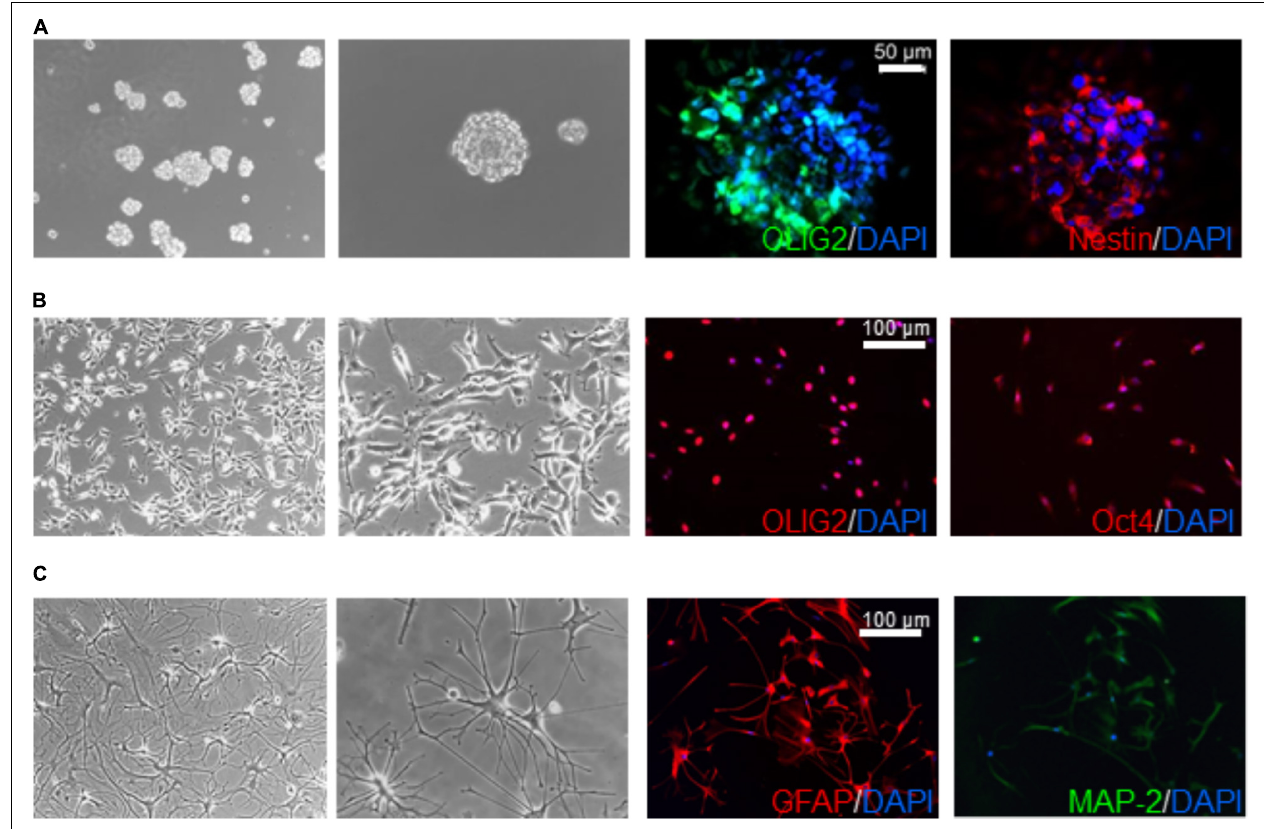
FIGURE 1 | Characterization of human glioblastoma stem cells. Representative images of GSC (derived from GBM6) spheroids (A) and monolayer on Matrigel (B) cultured in stem cell medium supplemented with EGF and bFGF and differentiated cells (C) obtained by switching culture conditions from growth factor-deprived to FBS-containing medium. Left panels reproduce phase contrast images at different magnification (10 × and 20 × ). Right panels depict immunofluorescence for stem cell markers OLIG2, nestin, and Oct4 (A,B) , and the glia (GFAP) and neuron (MAP-2) differentiation markers (C) . GFAP and MAP-2 expression is depicted from the same microscope field, showing in most cells the co-expression of both markers. Similar results were obtained analyzing all the GSC cultures that enter the